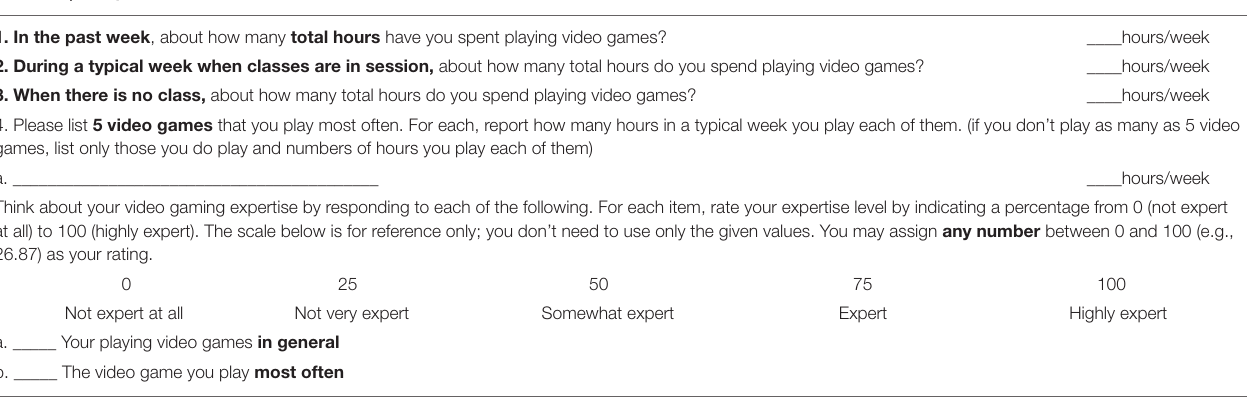
TABLE 1 | Sample items from first section of the VGPS.